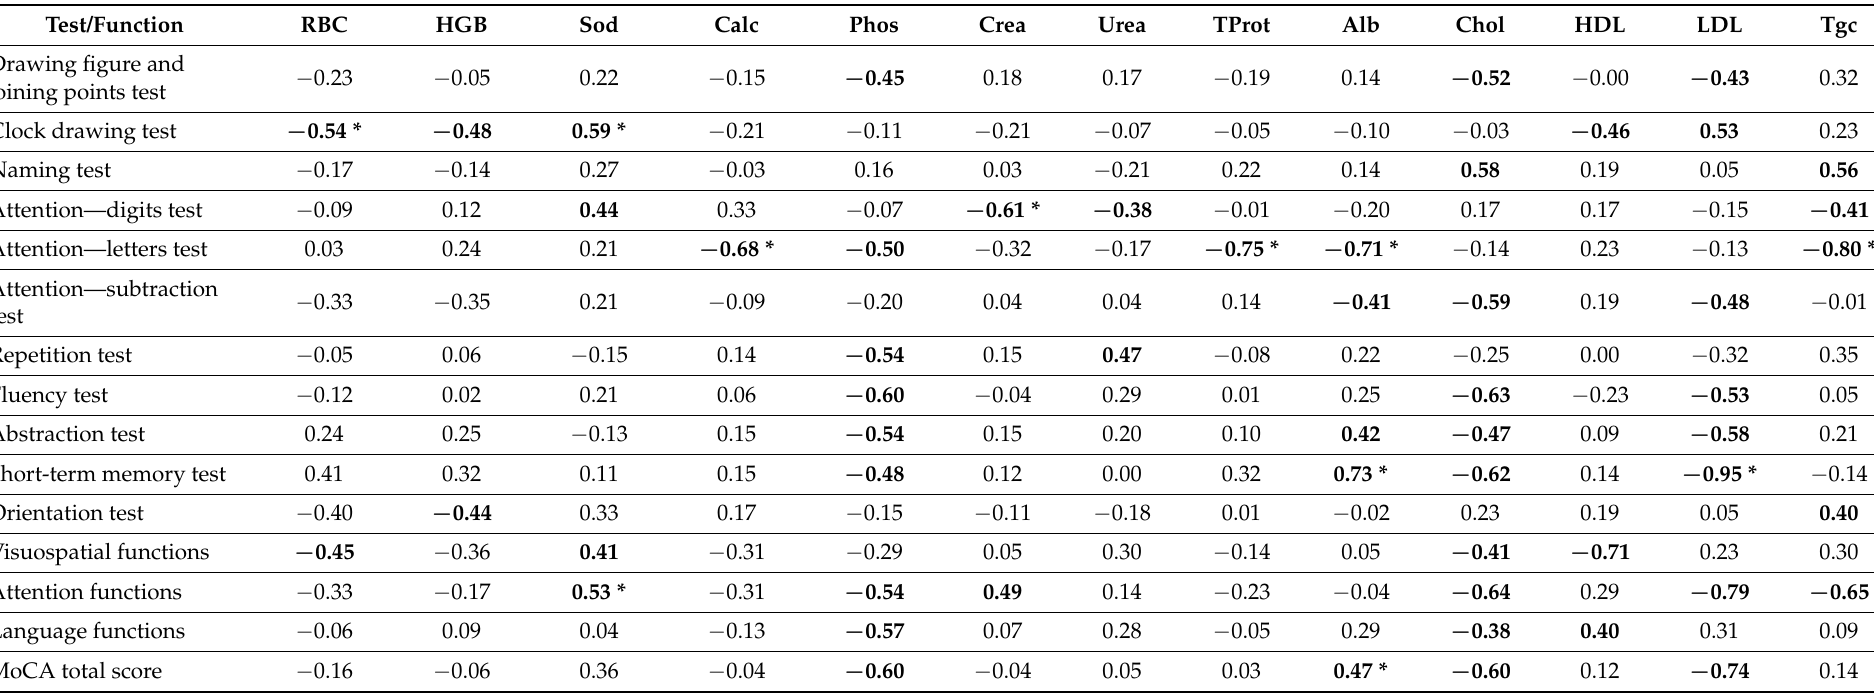
Table 3. Partial Pearson’s correlations between MoCA results and nutritional indicators with respect to age and the education